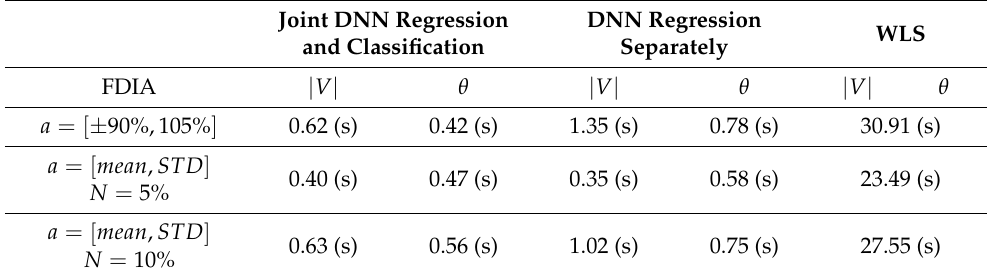
Table 4. Execution time for the proposed method, regression-only method, and WLS method.